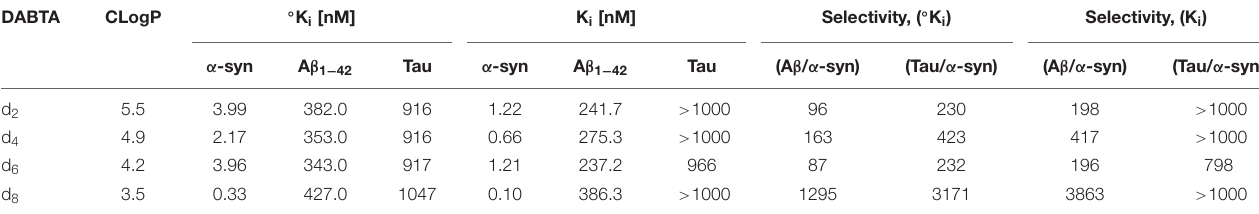
TABLE 3 | The calculated ( ◦ K i ) and experimental (K i ) binding affinity of the DABTAs to α -syn, A β , and tau fibrils with some physicochemical properties. DABTA CLogP ◦ K i [nM] K i [nM]